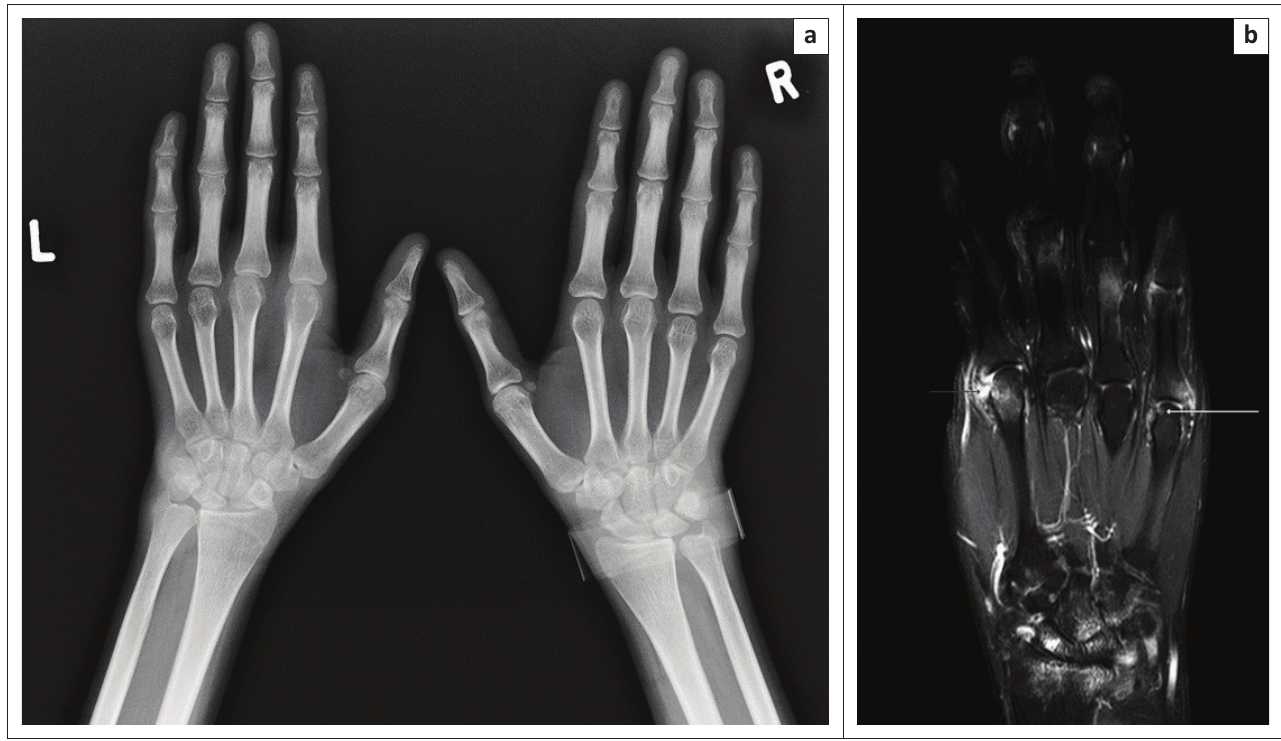
FIGURE 5: (a) Frontal radiograph of the both hands shows no evidence of erosive disease. (b) Post-contrast fat-suppressed coronal T1-weighted magnetic resonance imaging of the same hand demonstrating an erosion (white arrow) and active synovitis (grey